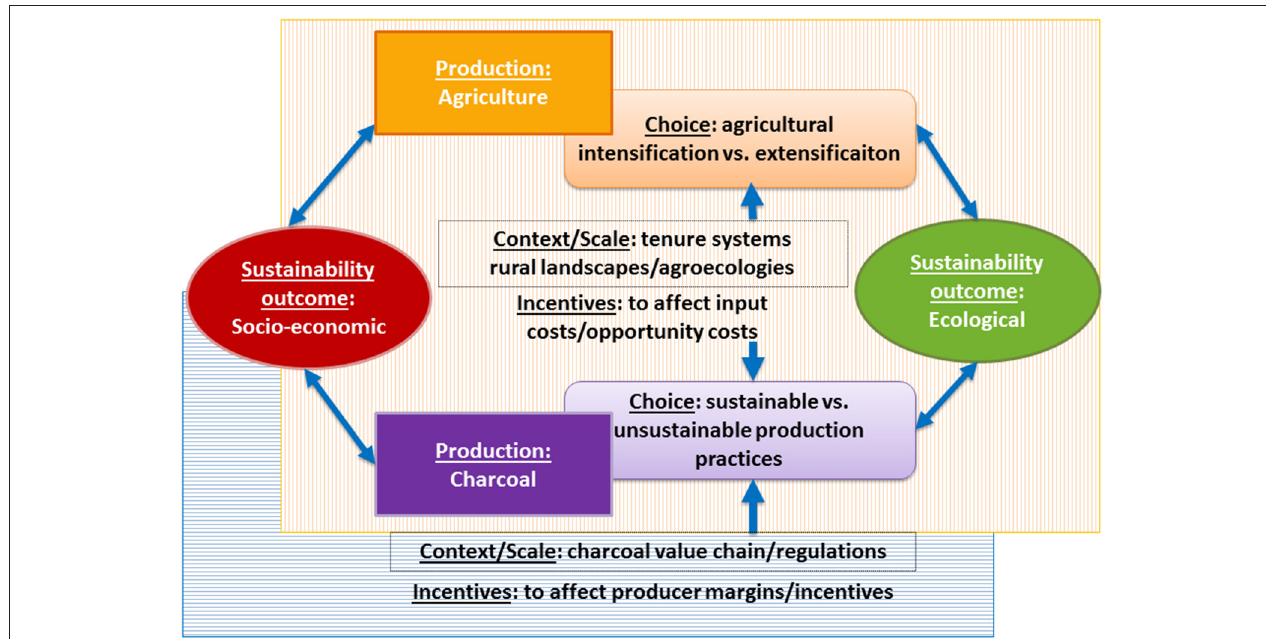
FIGURE 1 | The charcoal-agriculture production